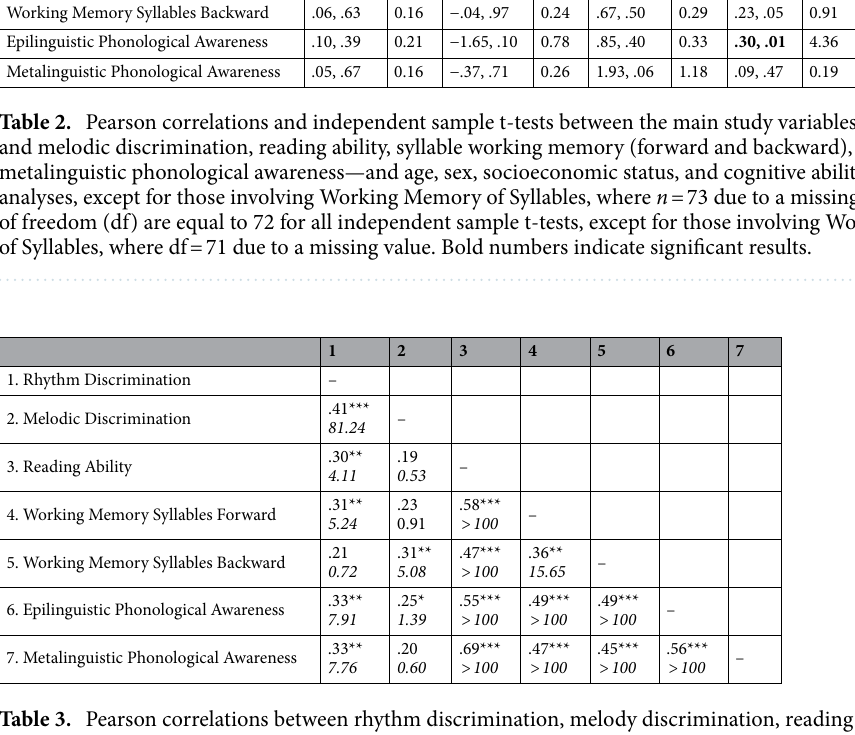
Table 3. Pearson correlations between rhythm discrimination, melody discrimination, reading ability, working memory for syllables (forward and backward), and epi- and metalinguistic phonological awareness, after removing the effects of cognitive ability (partial correlations). N = 74 for all analyses, except for those involving Working Memory of Syllables, where n = 73 due to a missing value. BF 10 values are indicated in italics. * p < .05; ** p < .01; *** p <